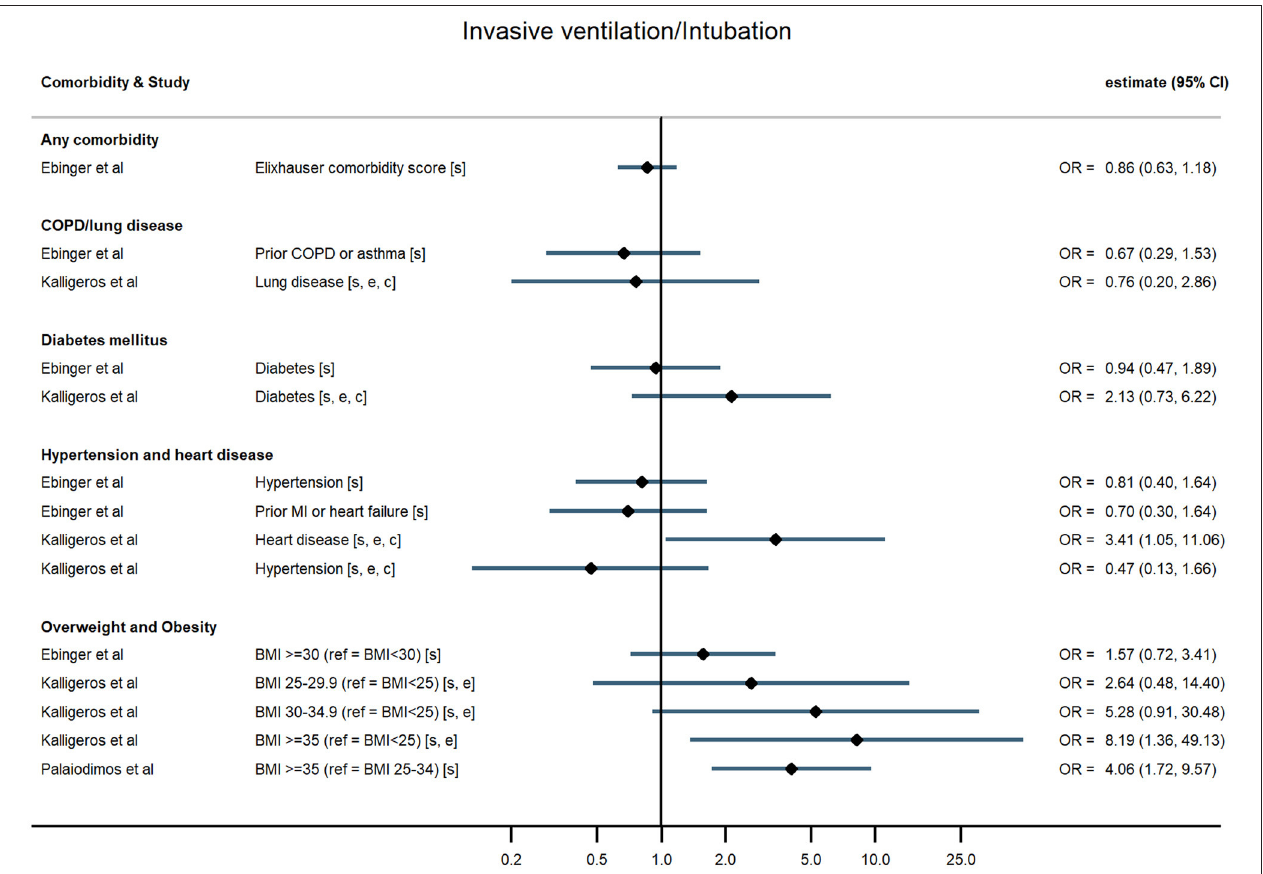
FIGURE 5 | Forest plot of study estimates of the association between comorbidities and invasive mechanical ventilation among hospitalized COVID-19 patients in the early stages of the pandemic. Reference category for each comorbidity is the absence of that comorbidity, except where stated otherwise. OR, odds ratio; CI, confidence interval; BMI, body mass index; COPD, chronic obstructive pulmonary disease; CVD, cardiovascular disease. All estimates adjusted for age. Additionally adjusted for: sex [s]; other comorbidities [c]; ethnicity